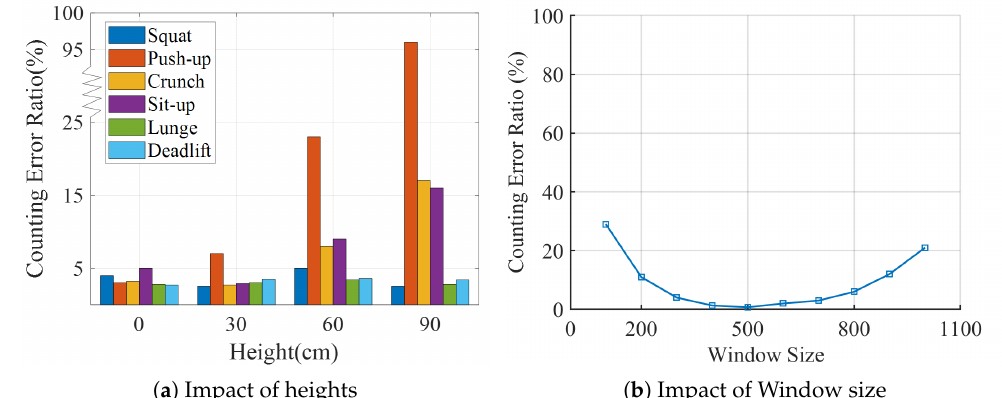
Figure 22. Impact of different deployment heights and window sizes.